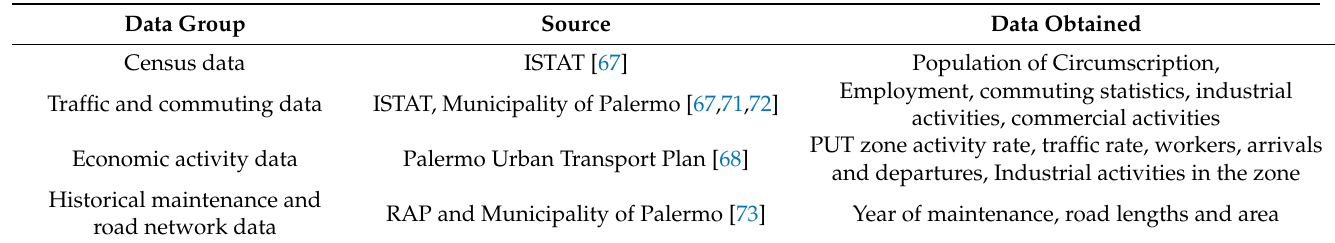
Table 3. Summary of Data